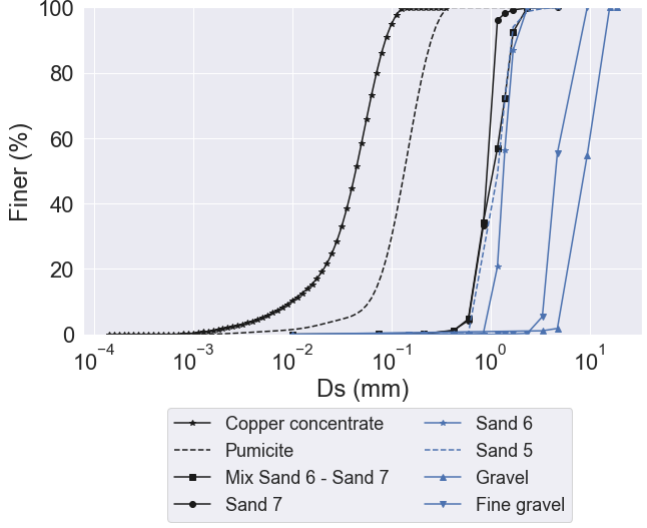
Figure 2. Grain size distribution of sediment and mineral